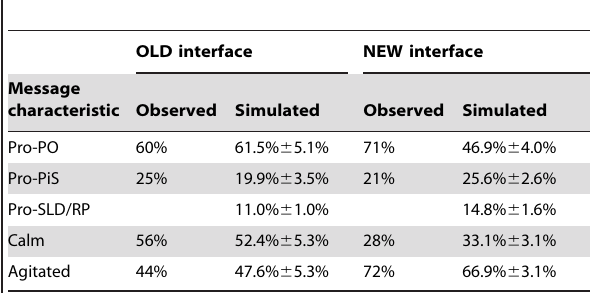
Table 5. Comparison of the observed and simulated agent characteristics for the OLD and NEW